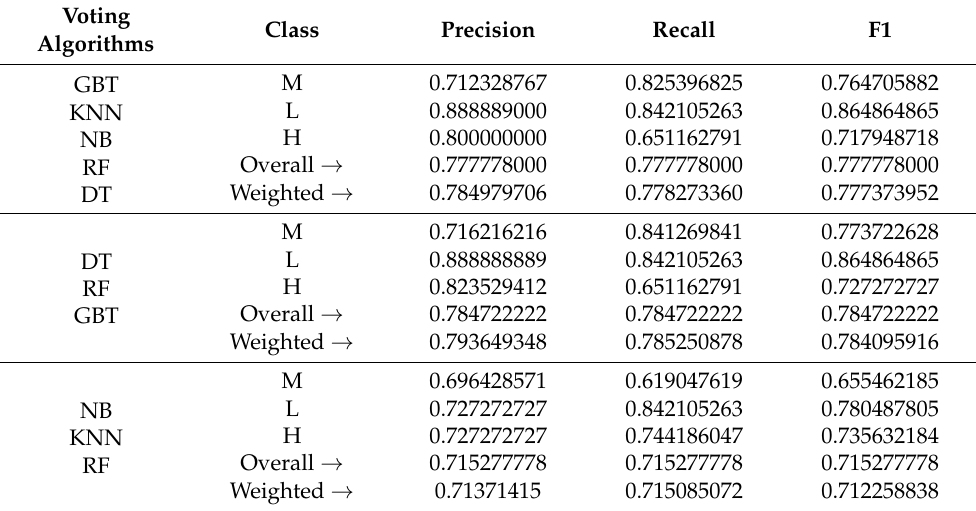
Table 7. Performance metrics for all ML models—with ensemble method IV